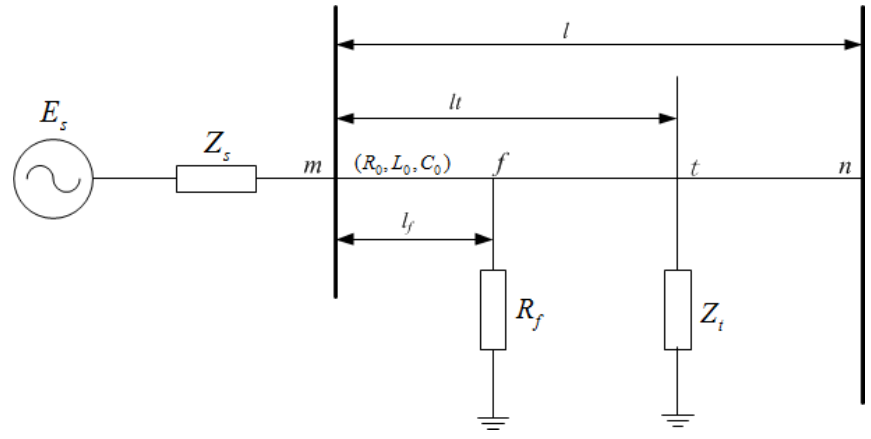
Figure 1. The equivalent model of the faulted traction